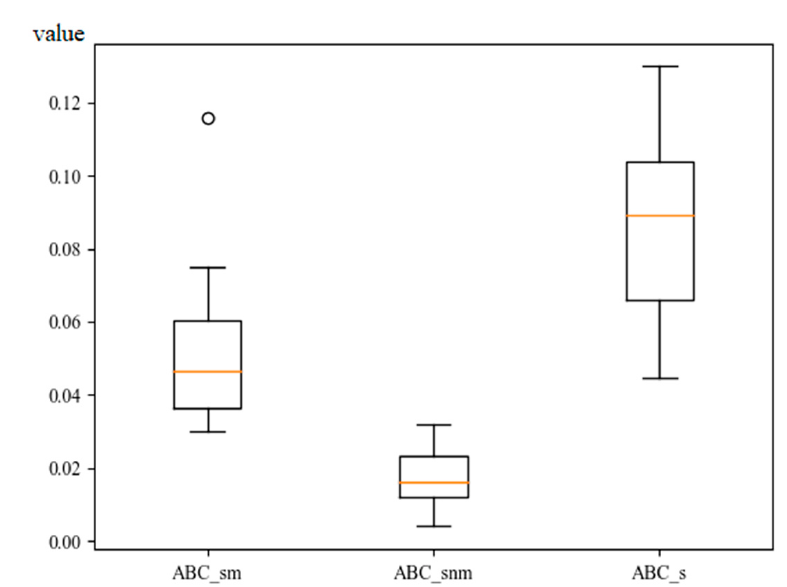
Figure 5. IGD -metric boxplot for ABC_sm, ABC_snm, and ABC_s.